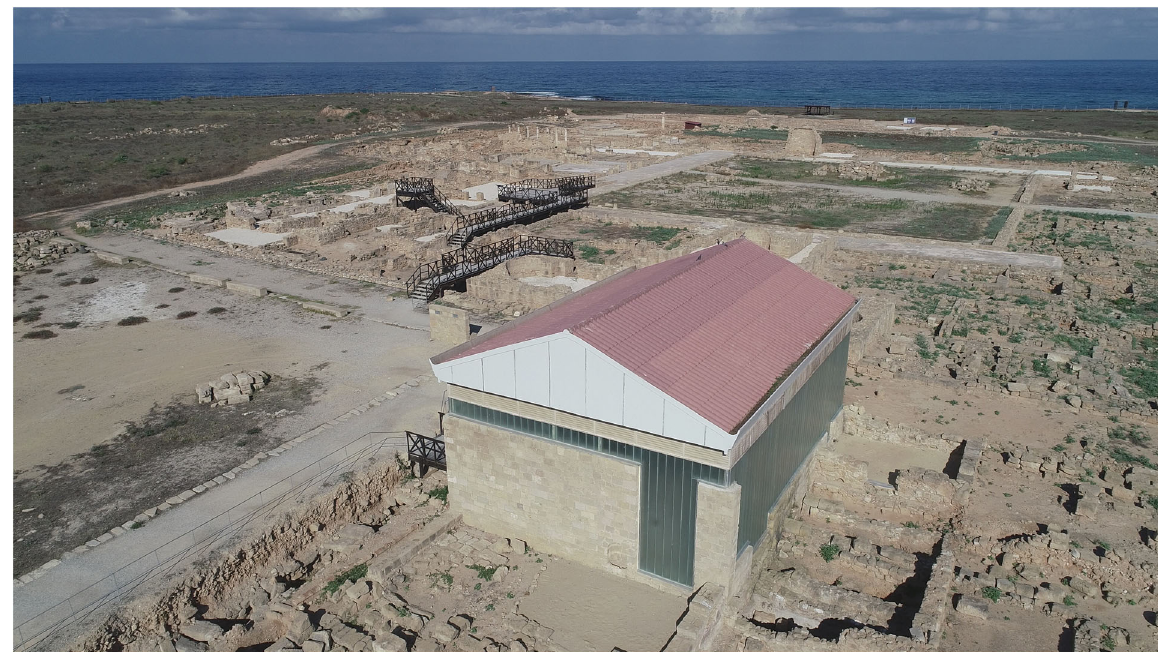
Fig. 9 View of the Aion House, Nea Paphos archaeological Site (Source: the